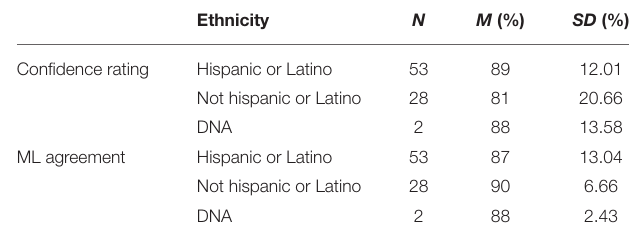
TABLE 5 | Confidence rating (OpenFace) and ML agreement as a function of